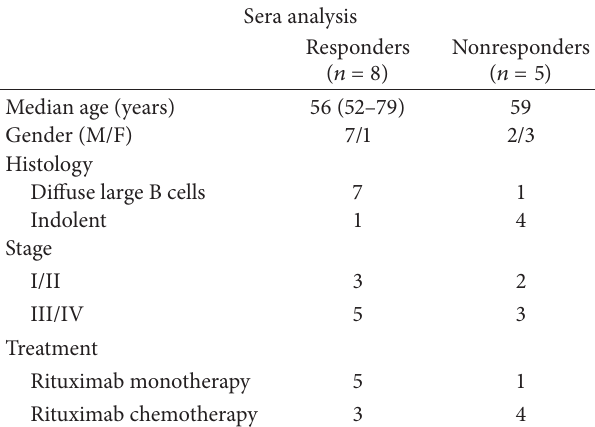
Table 2: B lymphoma patient